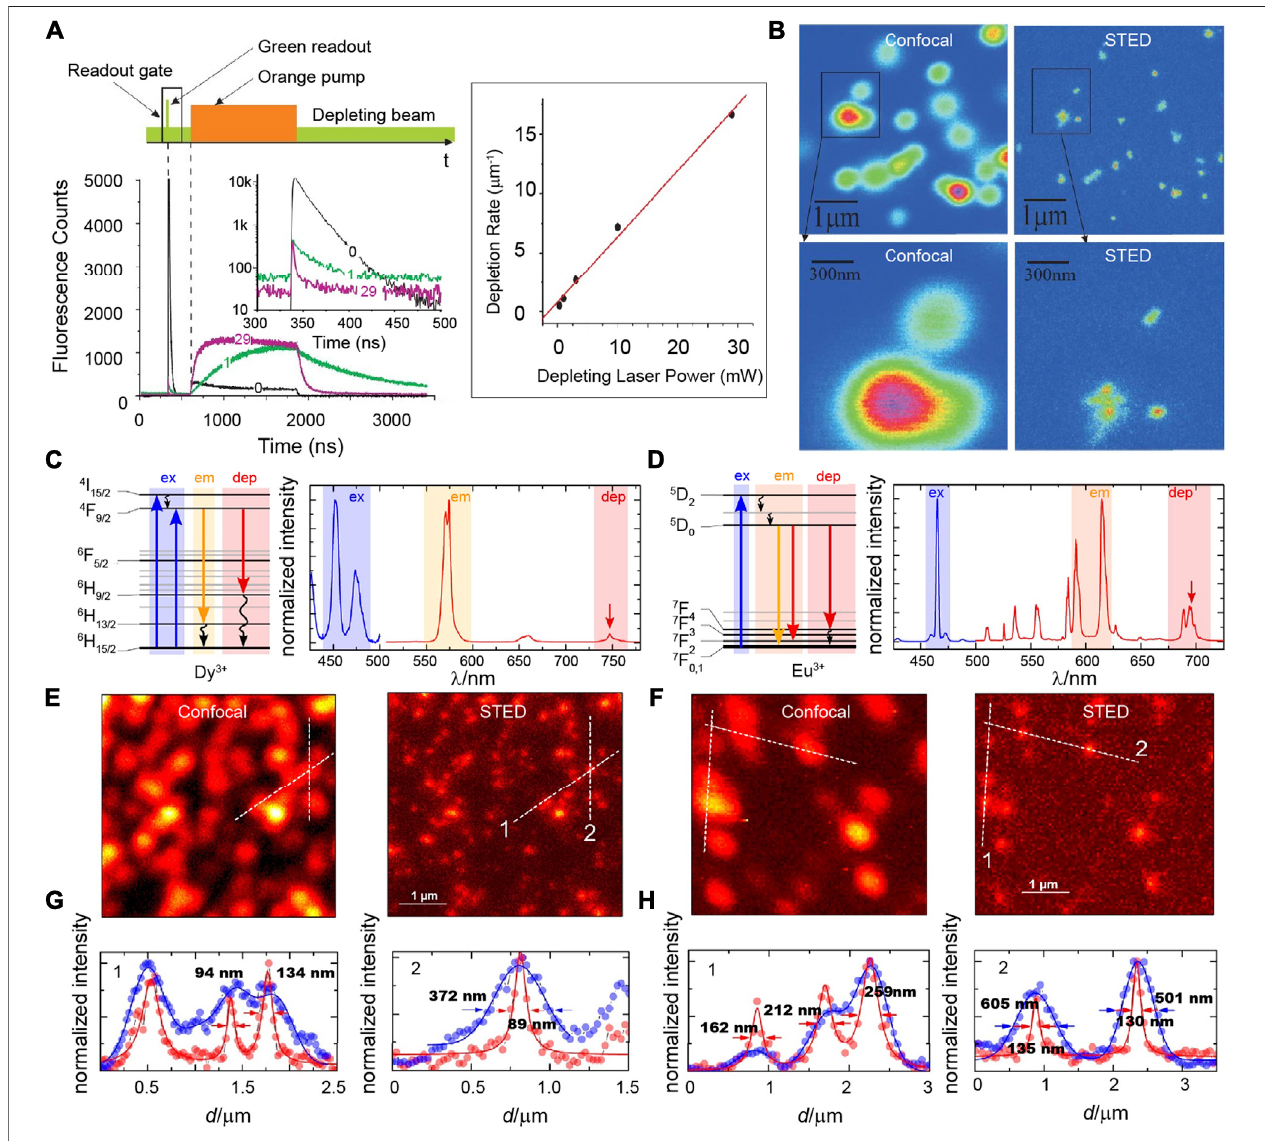
FIGURE 3 | (A) Excitation sequence of pulsed and continuous wave lasers in time – domain (upper) , the decay curves of upconversion luminescence at different times (lower) and the depletion rates at different laser powers. (B) Confocal (left) and STED (right) images of Pr : YAG fl uorescent nanoparticles. Adapted with permissions from the study by Kolesov et al. (2011). Simpli fi ed energy-level diagram (left) , excitation, and emission spectra (right) of (C) Dy 3+ and (D) Eu 3+ ions. Confocal (left) and STED (right) imaging of (E) NaYF 4 : Dy 3+ and (F) NaYF 4 : Eu 3+ nanocrystals at the same region. Intensity cross-section pro fi les of (G) NaYF 4 : Dy 3+ and (H) NaYF 4 : Eu 3+ nanocrystals of the dashed lines 1 and 2 in panels (E) and (F) . Adapted with permissions from the study by Stephan et al. (2019).